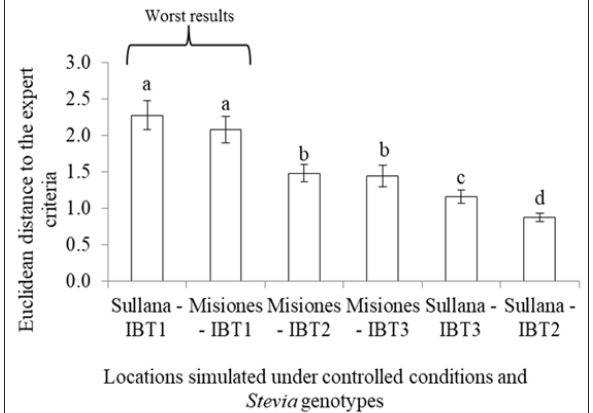
Figure 1 . Euclidean distance from each environment simulated and Stevia genotype to the expert criteria. Results with the same letter are not statistically different (Two-Way ANOVA, Student-Newman-Keuls, p>0.05), vertical bars represent